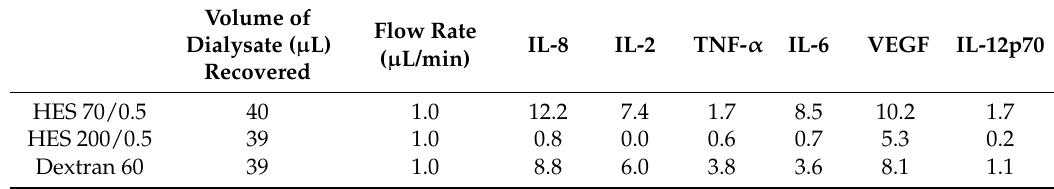
Table A2. Relative recovery (RR, %) from microdialysis after the careful dermal injection of 1600 pg/mL around the microdialysis membrane in anaesthetized domestic pigs in vivo. Microdialysis was thereafter performed at a flow rate of 1 µ